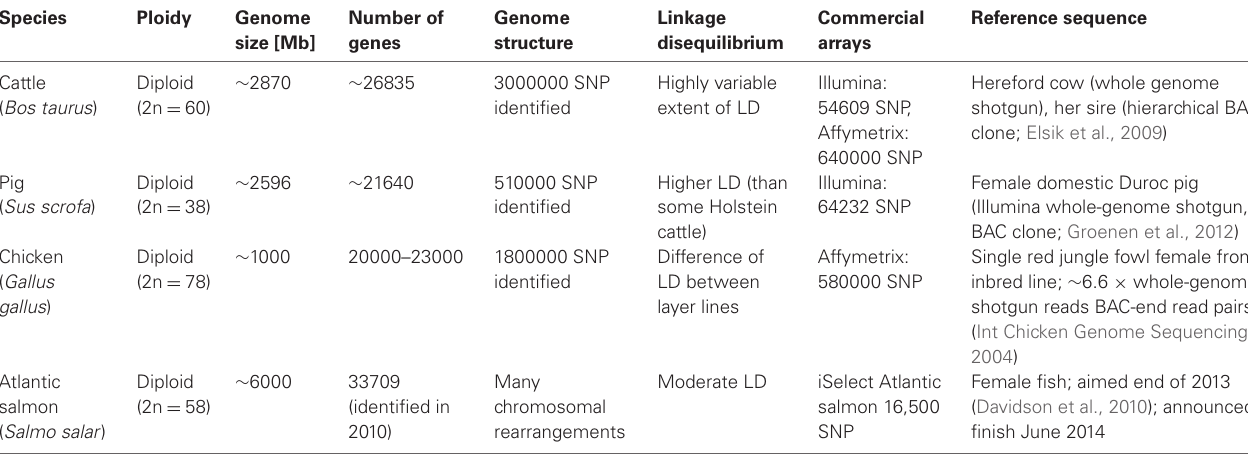
Table 1 | Overview of genome structure and genotyping platforms of the main livestock